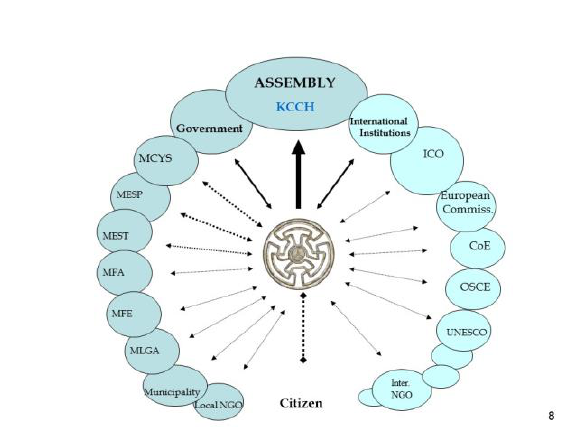
Figure 3. The situation of the Kosovo Council for Cultural Heritage KCCH expressed in an emotional organigram (Source: Edi Shukriu, 2013, ICOMOS South-East European Regional Conference)